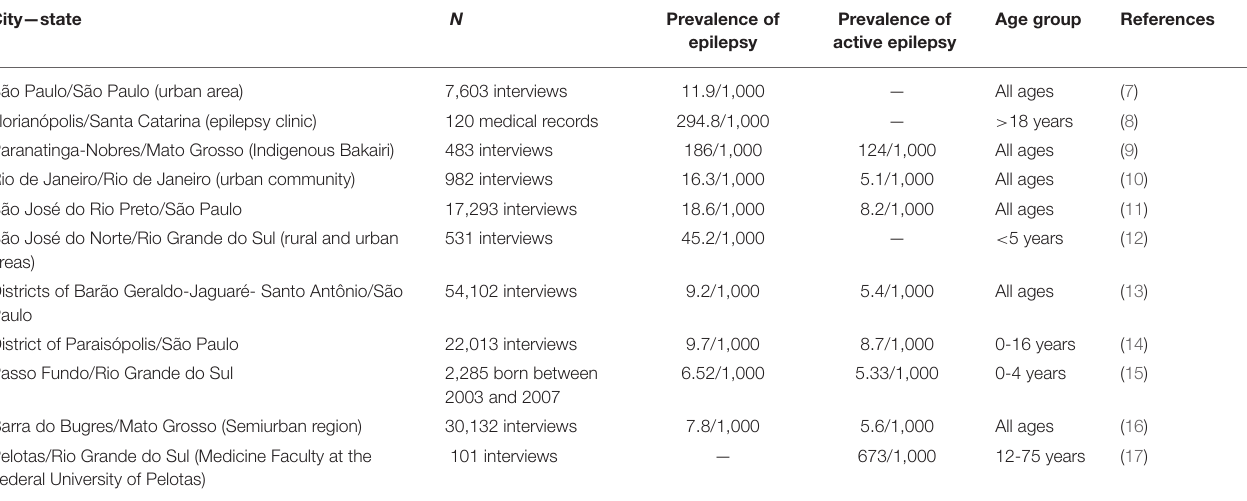
TABLE 1 | Prevalence of epilepsy in epidemiological studies in Brazil between 1986 and